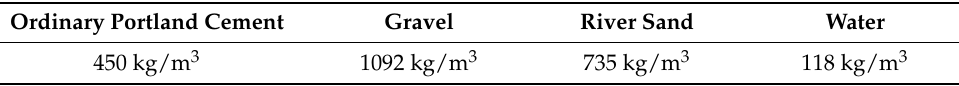
Table 1. Mix proportion of concrete.